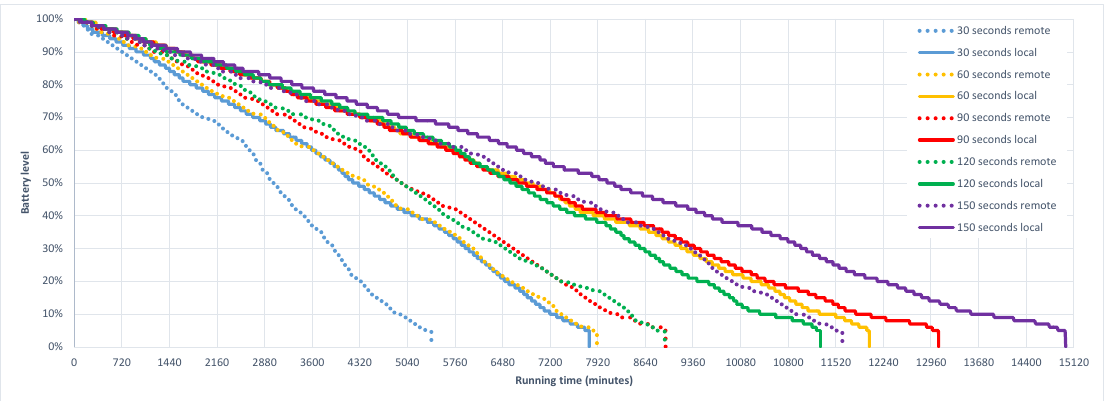
Figure 6. Energy performance comparison of on-device vs MCC oriented sample apps using different GPS sampling